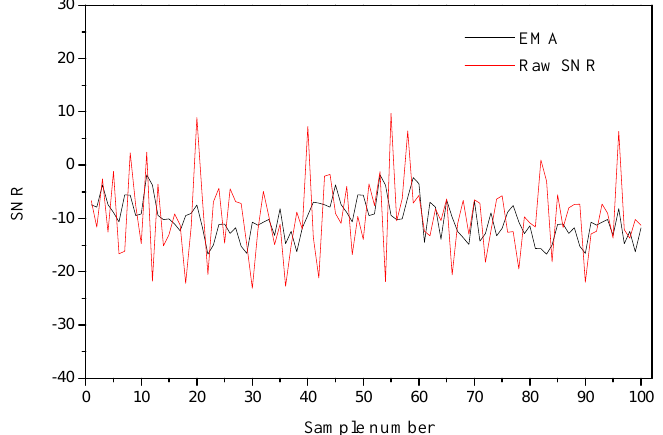
Figure 5. Smoothed SNR using exponential moving average-based (EMA) filter.